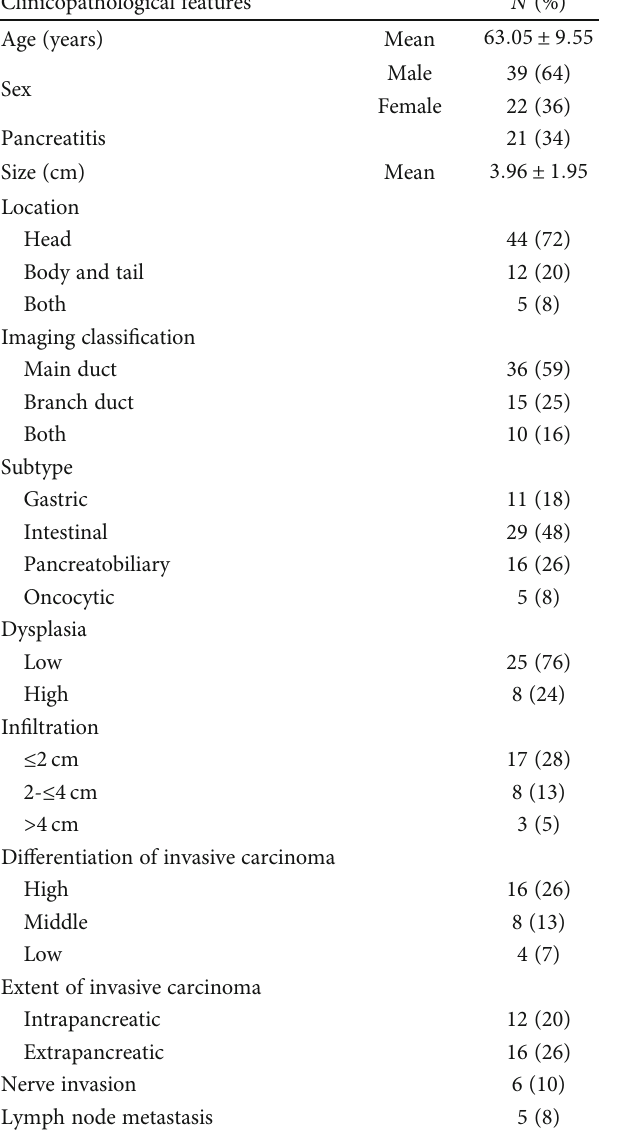
Table 3: Clinicopathological features of IPMN patients. Clinicopathological features